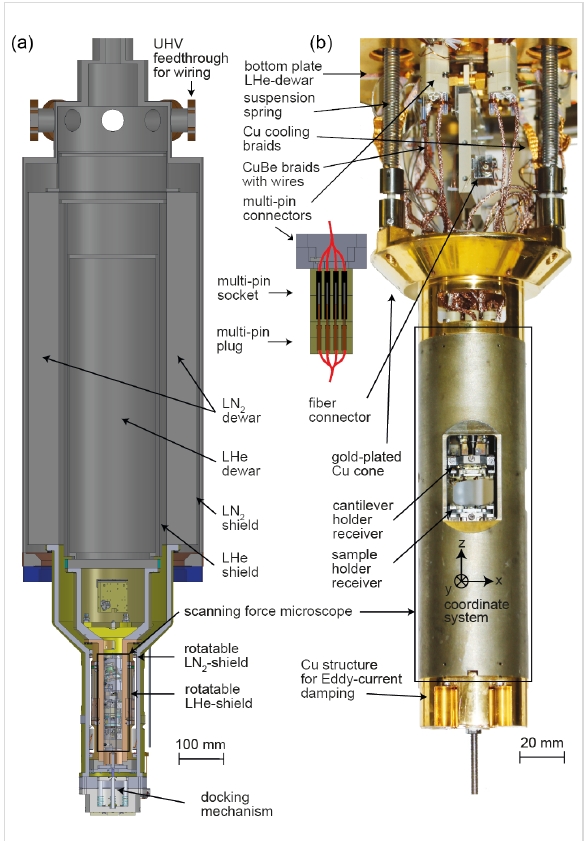
Figure 2: (a) The bath cryostat consists of two tanks, the inner tank holds 8 L of LHe and the outer tank holds 19 L of LN 2 , additionally with their own shields. The microscope is attached to the cone and hanging freely on three suspension springs as shown in the photograph (b).